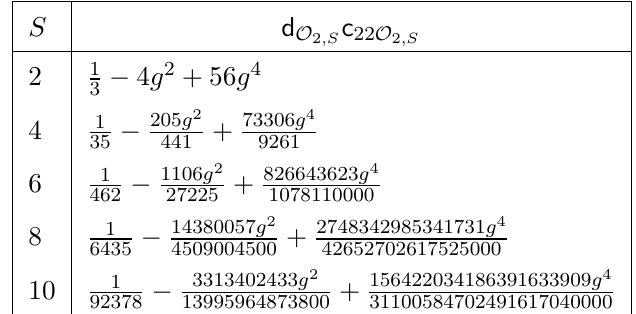
Table 2 . Products of structure constants d O c 22 O for spin S twist-2 operators O 2 ;S . As shown below, the results are completely rational in contrast to the OPE data for the single-trace four- point functions given in table 1 of [179]. (See also